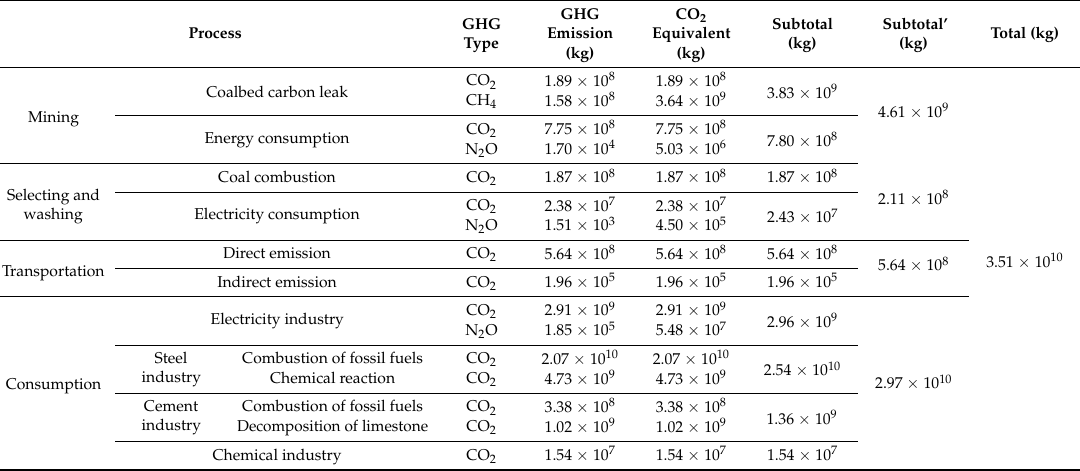
Table 5. Carbon emissions in the coal supply chains of